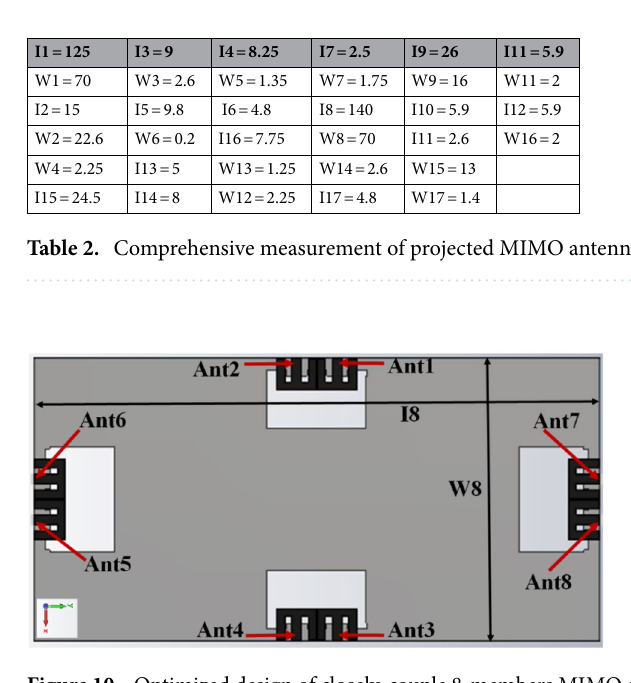
Figure 10. Optimized design of closely-couple 8-members MIMO